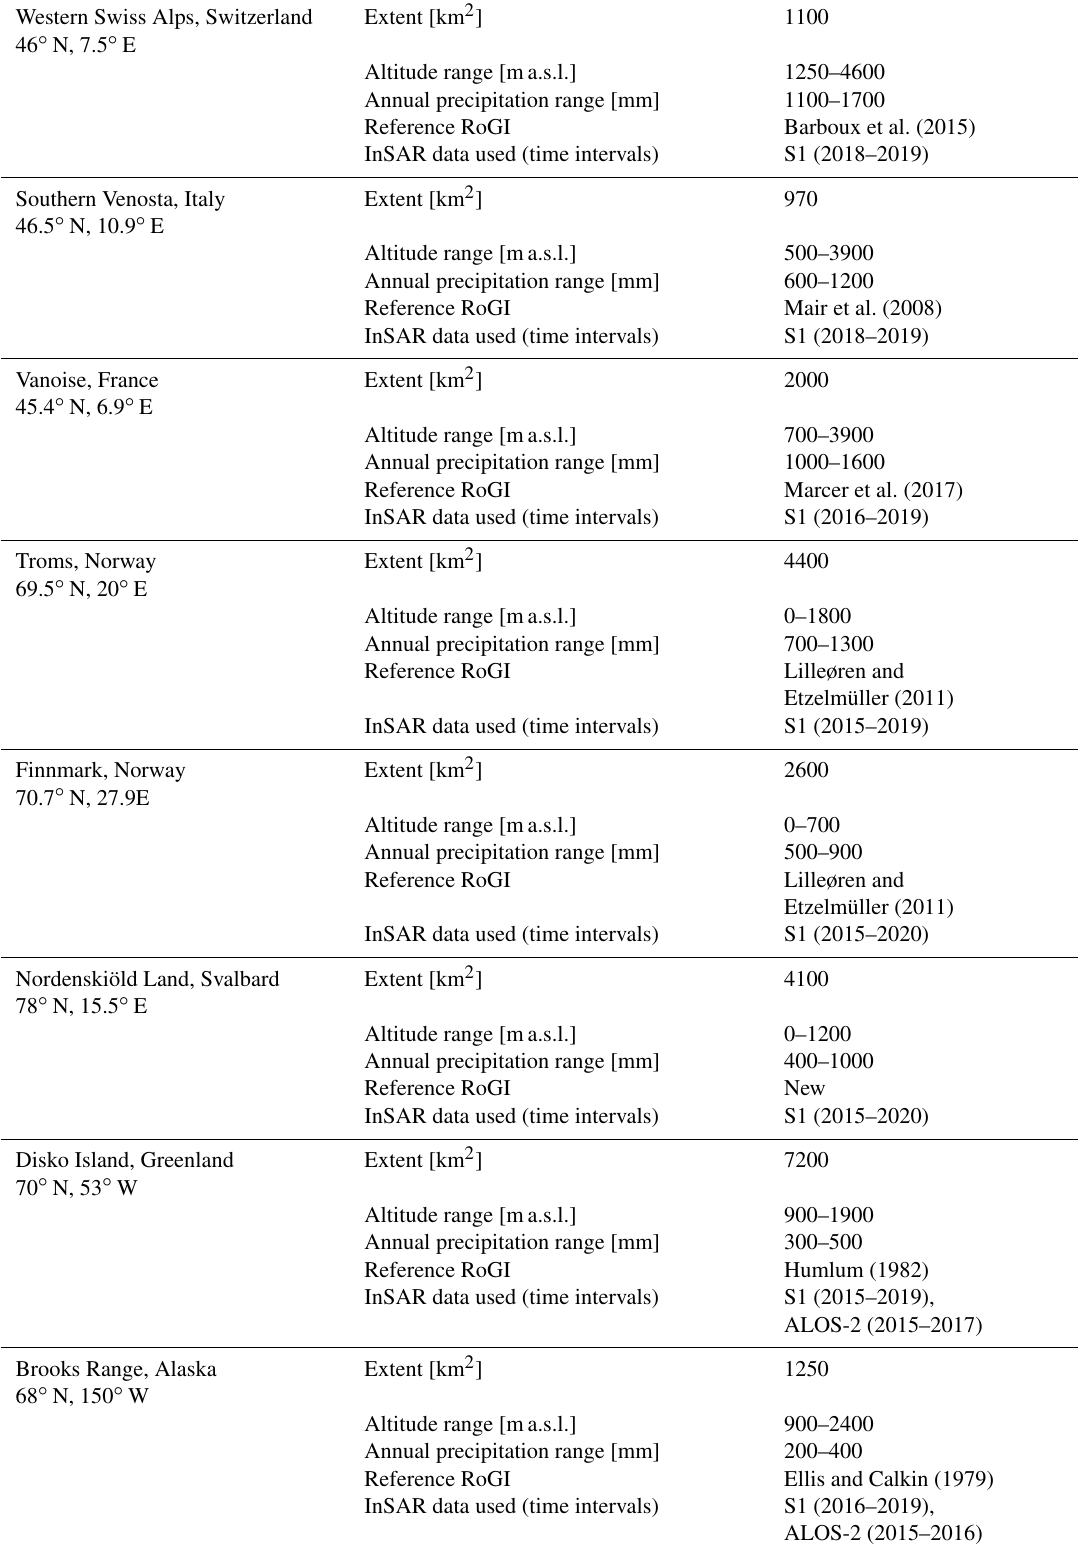
Table 1. Descriptions of geographic settings, RoGI references and InSAR data used for each investigated region. Western Swiss Alps,